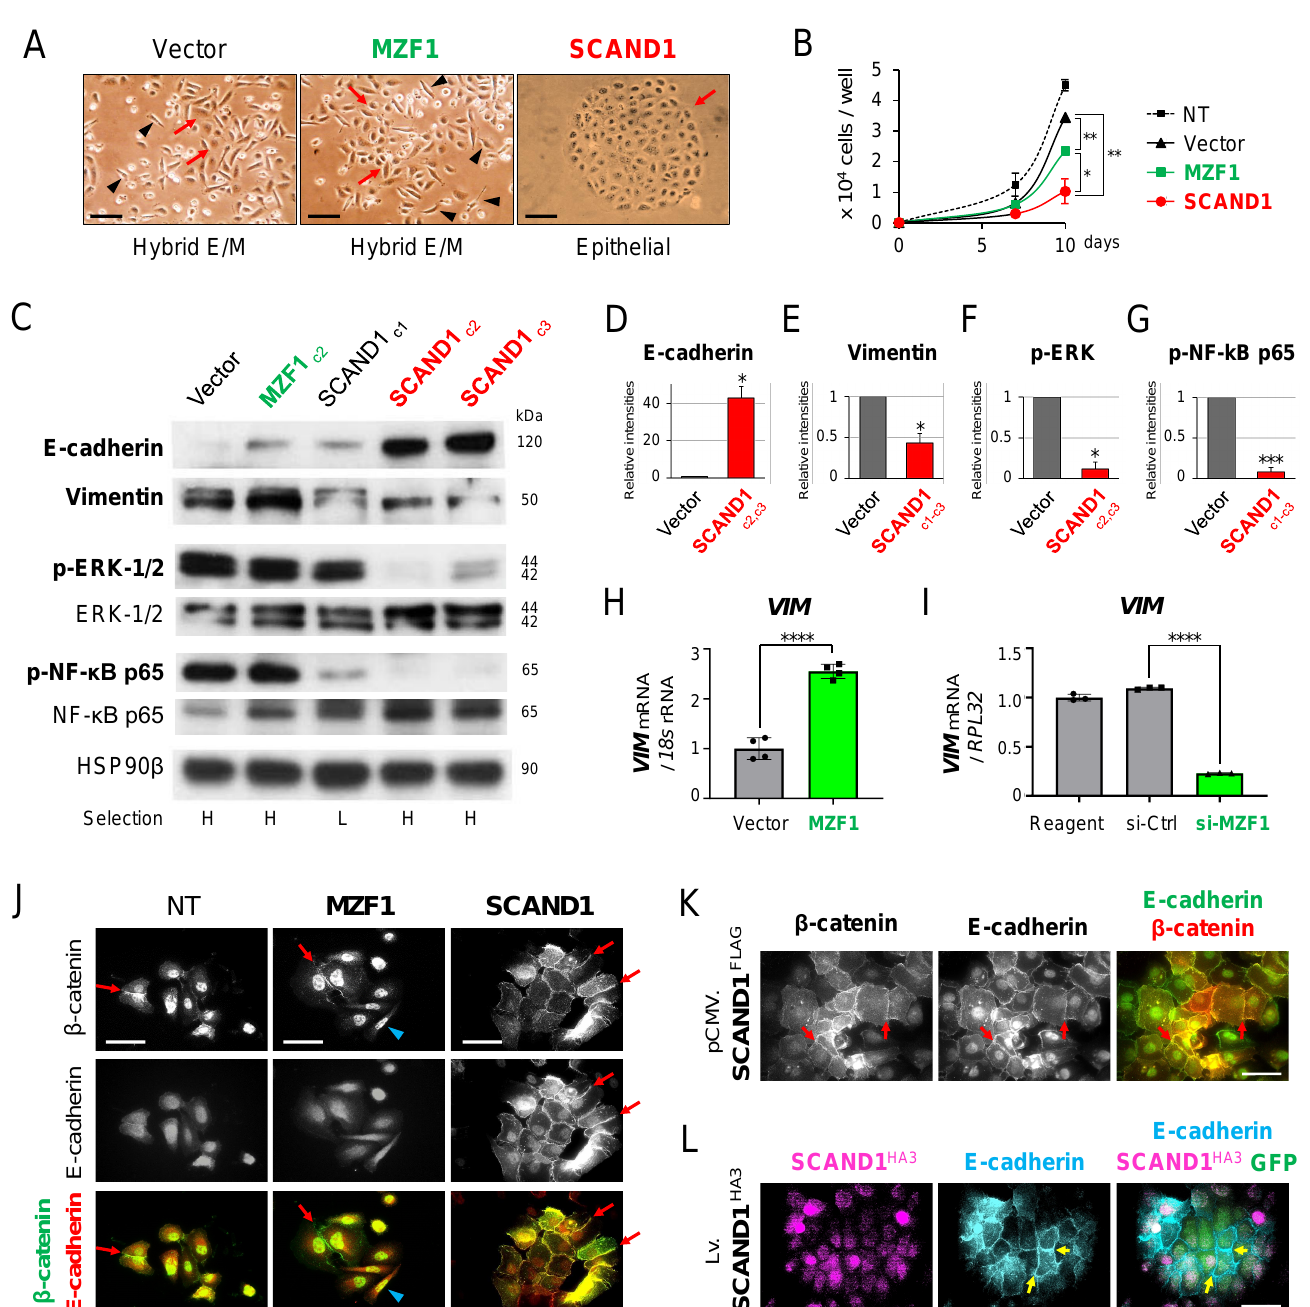
Figure 3. SCAND1 inhibits tumor cell proliferation and reverses EMT to establish epithelial adhesion. Plasmids for overexpressing SCAND1 Flag and MZF1 Flag or the control pcDNA3.1 vector were transfected into DU-145, and stable cells were cloned. ( A ) Morphologies of SCAND1- or MZF1- overexpressing and control vector-transfected DU-145 cells. Arrowheads indicate spindle-shaped mesenchymal cells. Red arrows indicate polygonal, cobblestone-like epithelial cells. Scale bars, 100 µ m. ( B ) Cell proliferation curves. NT, non-transfected cells. * p < 0.05, ** p < 0.01. ( C ) Western blotting showing E-cadherin, Vimentin, phosphorylated or total ERK-1/2 and NF- κ B p65. See Figure 2 for MZF1 and SCAND1 overexpression. HSP90 β , loading control. ( D – G ) Relative expression levels. Band intensities of Western blotting were quantified. *** p < 0.005, n = 3. * p < 0.05, n = 2 or 3. ( H , I ) VIM mRNA expression altered by MZF1 expression plasmid ( H ) or siRNA ( I ) transfected in DU-145 cells. **** p < 0.001, n = 4. ( J – L ) Confocal microscopy showing subcellular co-localization of β -catenin vs. E-cadherin ( J , K ) and SCAND1 HA3 vs. E-cadherin ( L ). Arrows indicate intercellular adhesion. Blue arrowheads indicate spindle-shaped cells. Scale bars, 100 µ